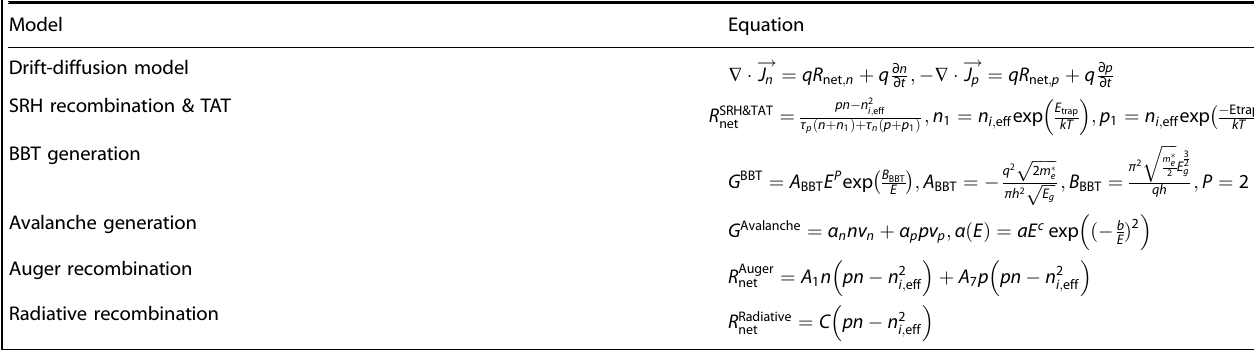
Table 1. Current transport models.